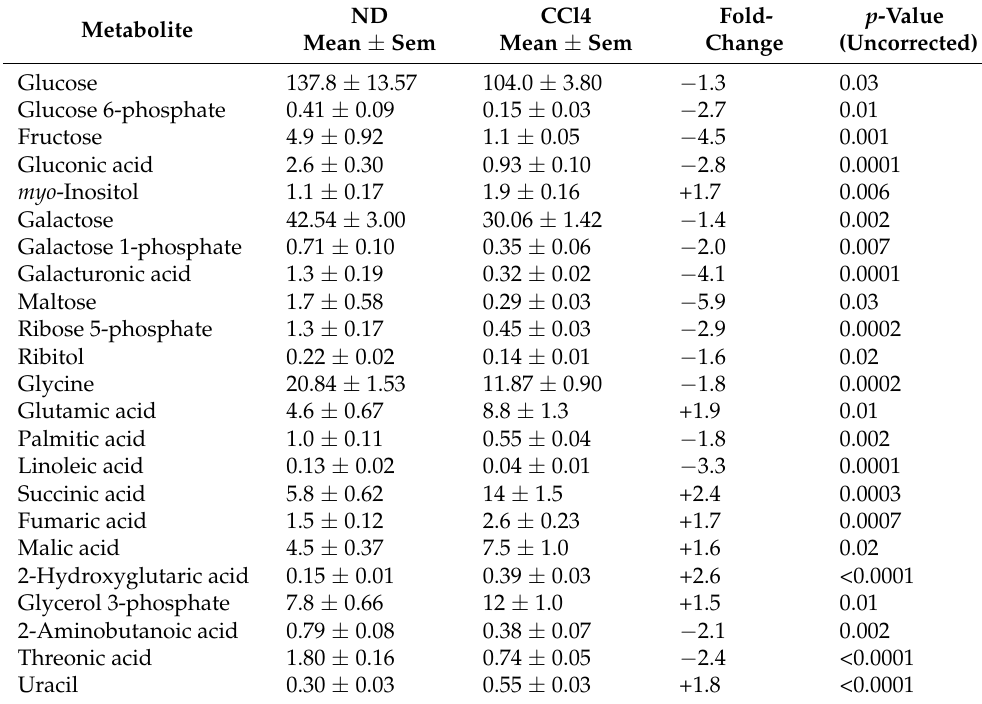
Table 1. Hepatic metabolite levels on a normal diet only (ND) and after administration of carbon tetrachloride